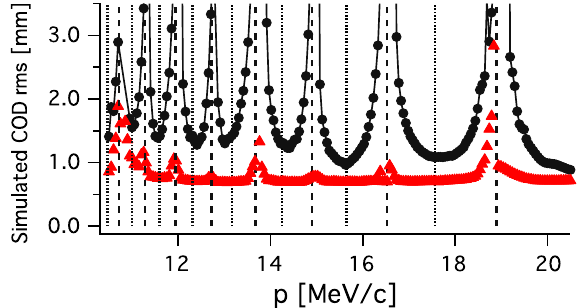
FIG. 3. Example of correction of multiple harmonics of the COD in the horizontal plane. From left to right, the eight peaks are associated with integer resonances 13 – 6. At each momentum, the closed orbit is found at simulated BPMs located in between each quadrupole doublet in the presence of magnet misalign- ments with standard deviation 0.1 mm. Since the 42 BPMs are symmetrically located in each cell, the closed orbit is identical in the case of an ideal lattice. Imperfect measurements are intro- duced by including BPM offsets ( σ ¼ 0 . 7 mm) and an additional statistical error ( σ ¼ 0 . 2 mm). The former is fixed for a given BPM, while the latter varies with every data point taken. These parameters were chosen to approximate those in the real machine. The rms of the resulting COD is then calculated at each momentum. The black circles and red triangles show this quantity before and after correction, respectively. Harmonics 6 – 13 are corrected, by following the method described in the algorithm, since they are within the tune range of EMMA. The correction is applied by moving the D quadrupoles horizontally with finite error ( 10 μ m). The momenta at which the horizontal tune is integer and half-integer is shown by the vertical dashed and dotted lines,